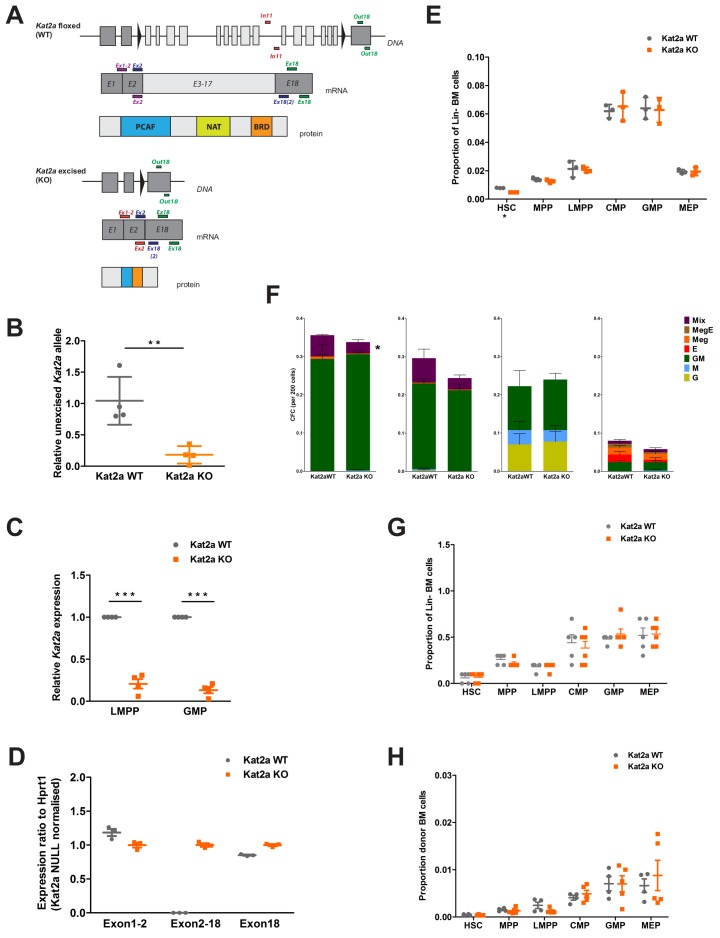
Loss of Kat2a does not affect normal hematopoiesis.(A) Diagram of conditional Kat2a floxed (WT) and Kat2a-excised (KO) alleles, including excision detection strategy and diagrams of the transcript and protein generated upon Kat2a locus excision. Kat2a IN (In11, within excised region) and Kat2a OUT primers (Out18, downstream of excised region) used in qPCR analysis of genomic DNA. Amplicons generated by primer pairs Ex1−2/Ex2 (red), Ex2/Ex18(2) (blue) and Ex18 (green) distinguish WT from KO transcript. (B) Excision efficiency quantified by qPCR in mouse BM samples, mean ± SEM, n = 4, **p<0.01. (C) Quantitative RT-(q)PCR analysis of Kat2a transcript levels in BM LMPP and GMP; mean ± SEM, n = 4, **p<0.001. (D) RT-qPCR analysis of red, blue and green amplicons in A for diagnosis of Kat2a WT and KO AML samples, mean ± SEM, n = 4. (E) Flow cytometry analysis of stem and progenitor BM composition in Kat2a WT and KO young mice (6 weeks after pIpC treatment), mean ± SEM, n = 3’ *p<0.05. (F) Colony-forming assays of progenitor populations (left to right: HSC, MPP, GMP and MEP) isolated from Kat2a WT and KO BM 4–6 weeks after excision, mean ± SEM, n = 4–5, *p<0.05. (G) Flow cytometry analysis of stem and progenitor BM composition in Kat2a WT and KO old mice (>4 months after pIpC treatment), mean ± SEM, n > 5. (H) Flow cytometry analysis of donor-derived BM stem and progenitor cells in a long-term hematopoietic reconstitution assay. Irradiated recipients were transplanted with Kat2a WT or KO cells and analyzed 16–20 weeks later; mean ± SEM, n = 4–5. Two-tailed t-test was performed in (B), (C), (E) and (F).Figure 1—figure supplement 1—source data 1.Colony-forming assays of Kat2a WT and KO stem and progenitor cells.